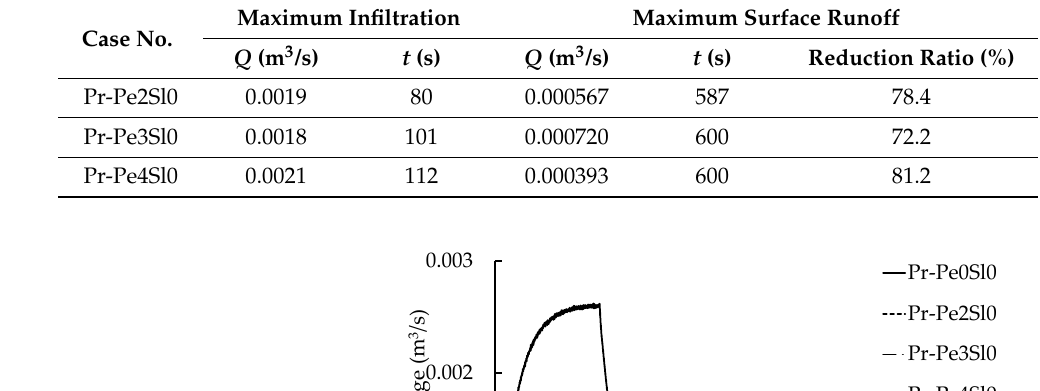
( b ) Figure 20. Results of IRD system prototype model: ( a ) infiltration; ( b ) surface runoff. Table 10. Results infiltration and surface runoff ratios. Ratios (%)